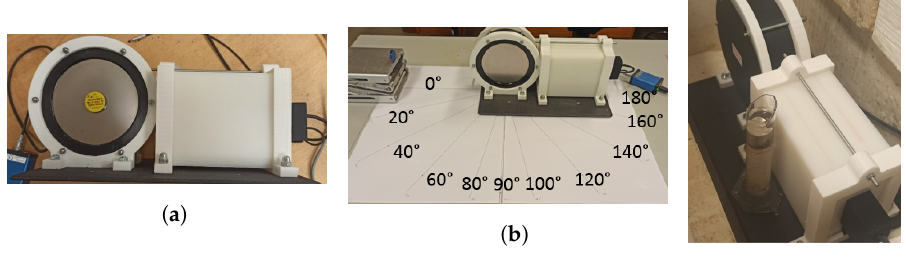
Figure 8. Laboratory tests performed to the developed radiation detection system. ( a ) 137 Cs source placed next to the EJ-200 detector window. ( b ) EJ-200 response (counts) to a 137 Cs source by varying the source–detector angle. ( c ) EJ-426HD neutron detection system spectrum acquisition using a 33 MBq (0.9 mCi) Am-Be source.